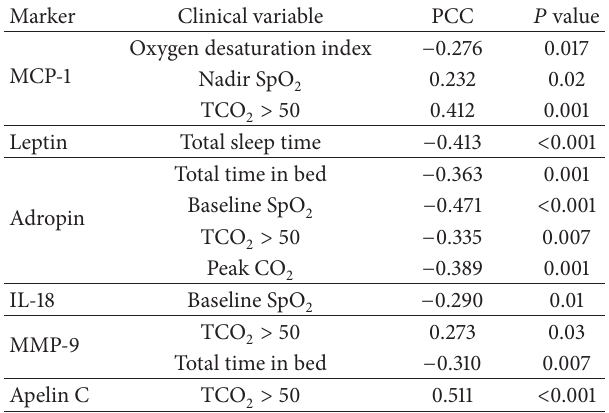
Table 4: Univariate associations among inflammatory markers and PSG measures in children with